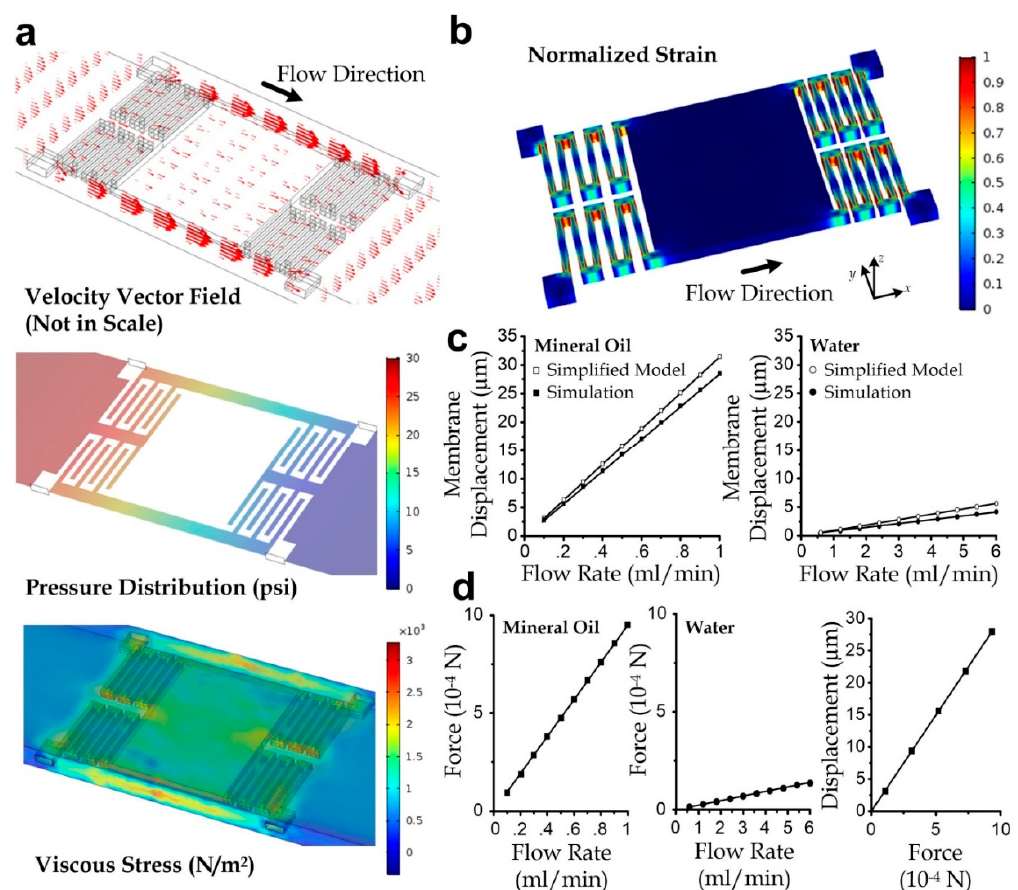
Figure 2. ( a ) Velocity, pressure, and viscous stress profiles around the micromembrane supported by the three-folded beams at a flow rate of 0.3 mL / min. ( b ) Strain distribution of the suspending membrane along the microchannel. ( c ) Membrane displacements as a function of the flow rate, calculated by simulation and the simplified model. ( d ) Resultant force acting on the membrane as functions of the flow rate and membrane